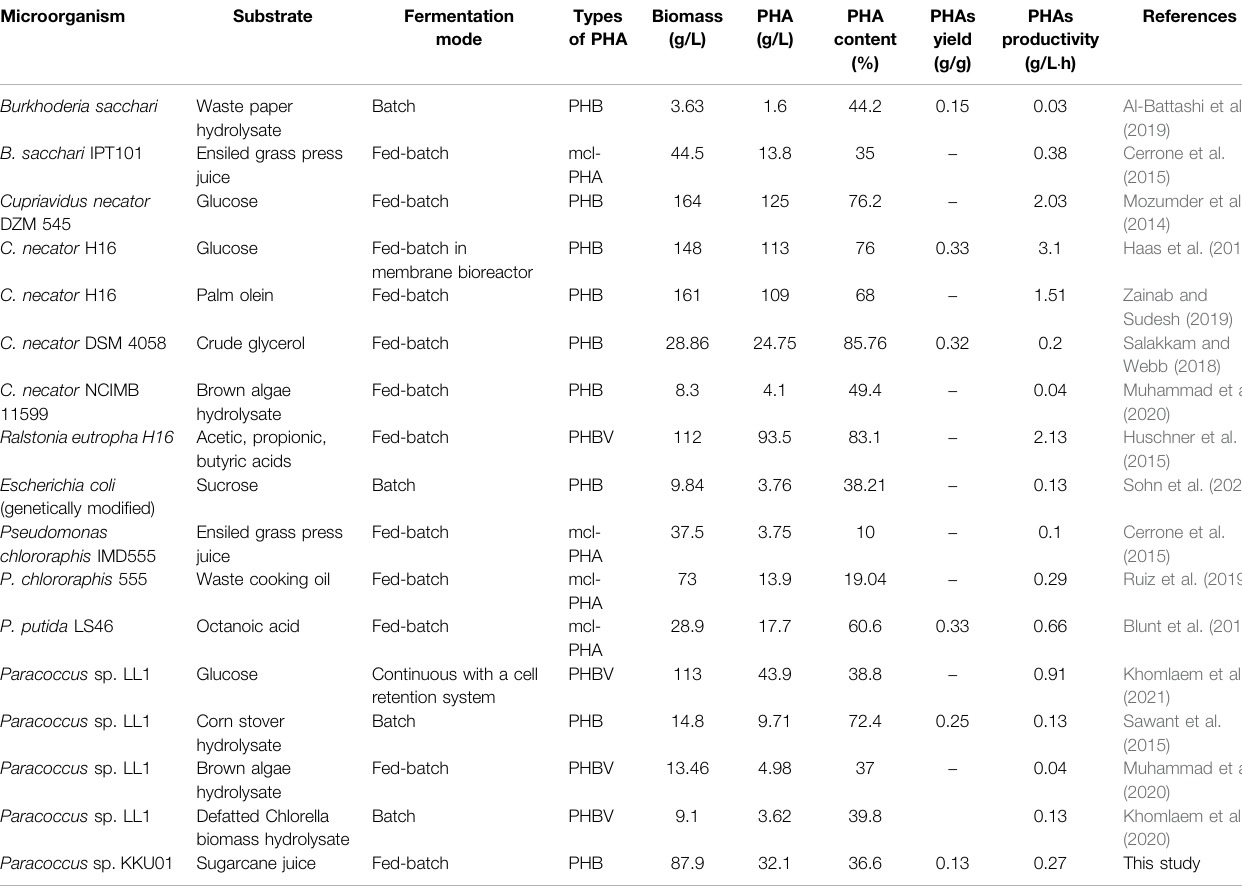
TABLE 6 | Polyhydroxyalkanoates (PHAs) production by